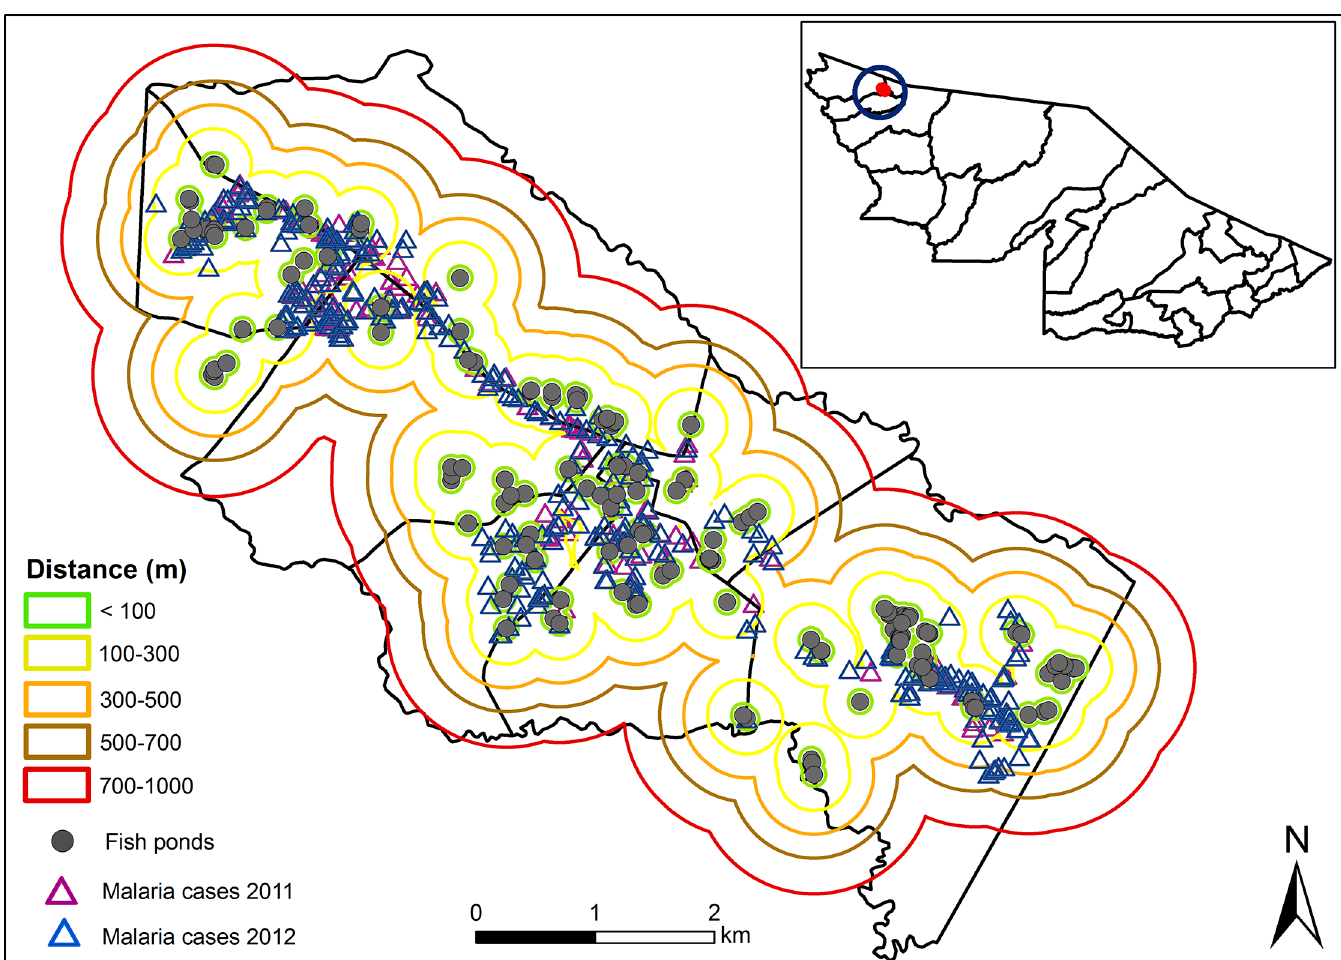
Fig 6. Buffer zone from 100 to 1000m around breeding sites in the urban/periurban area of Mâncio Lima, and malaria cases in 2011 and 2012.